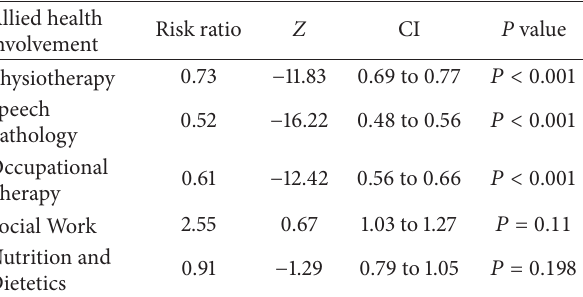
Table 2: Allied health involvement: odds ratios ASU versus non- ASU stroke